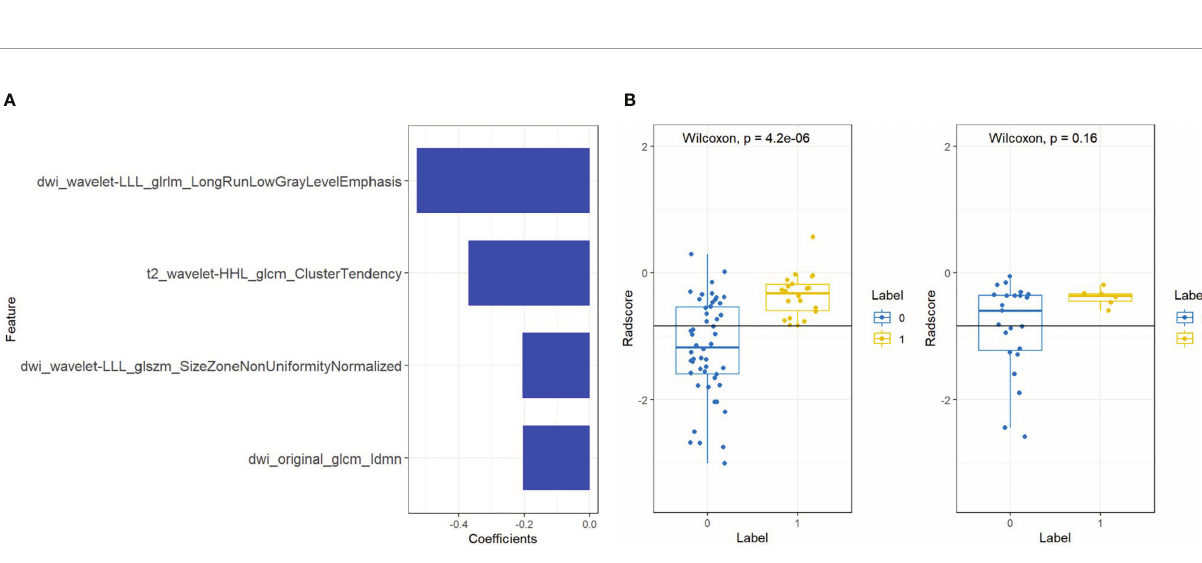
FIGURE 3 | Features and radiomics labels used in bpMRI model. (A) Imaging characteristics screened by bpMRI model. (B) comparison of Radscore between training set (left) and testing set (right). The blue label represents benign lesions or ciPCa, and the yellow label is